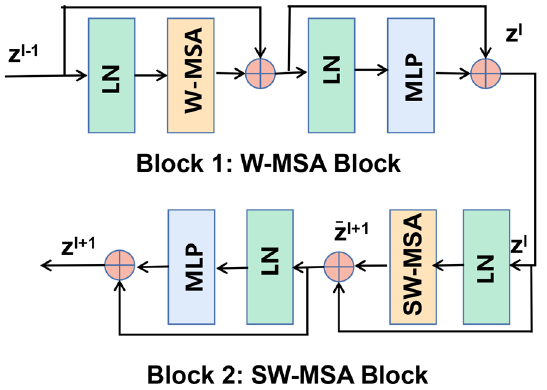
Figure 6. Swin transformer Block structure.